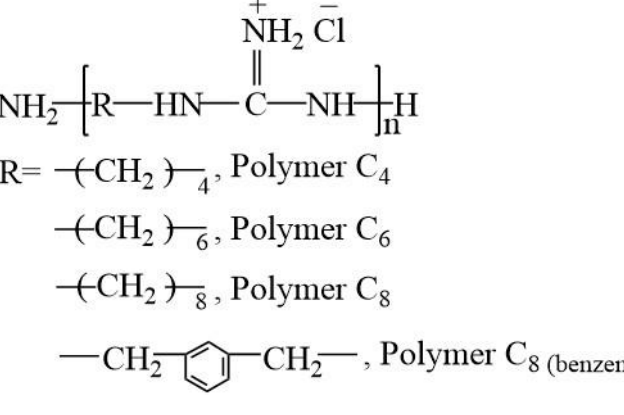
Figure 1. The chemical structure of four oligoguanidine polymer analogs: Polybutamethylene guanidine hydrochloride (Polymer C 4 ); Polyhexamethylene guanidine hydrochloride (PHGH, Polymer C 6 ); Polyoctanethylene guanidine hydrochloride (POGH, Polymer C 8 ); Poly(m-xylylene guanidine hydrochloride) (Polymer C 8(benzene)